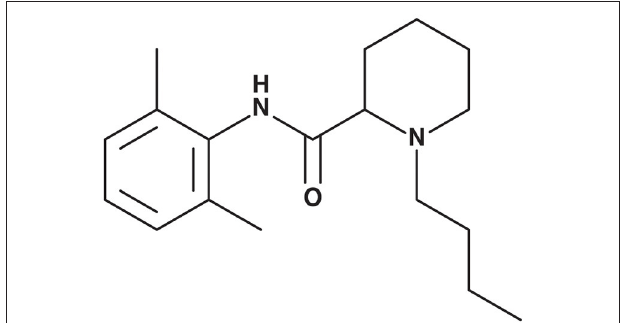
FIGURE 1 | Bupivacaine structure